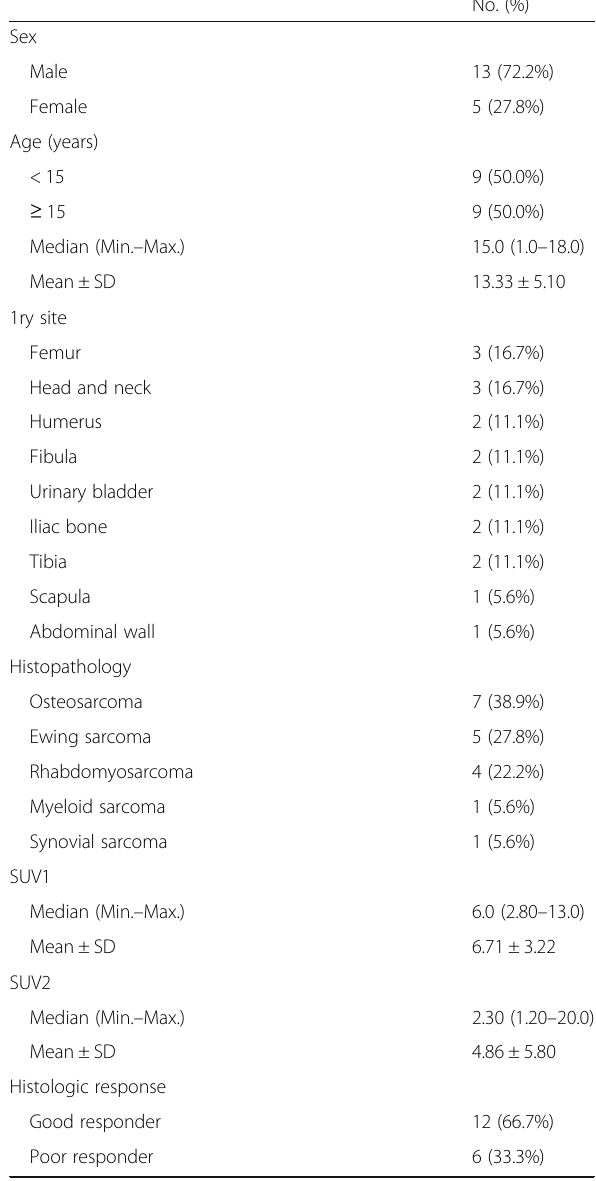
Table 1 Distribution of the studied cases according to